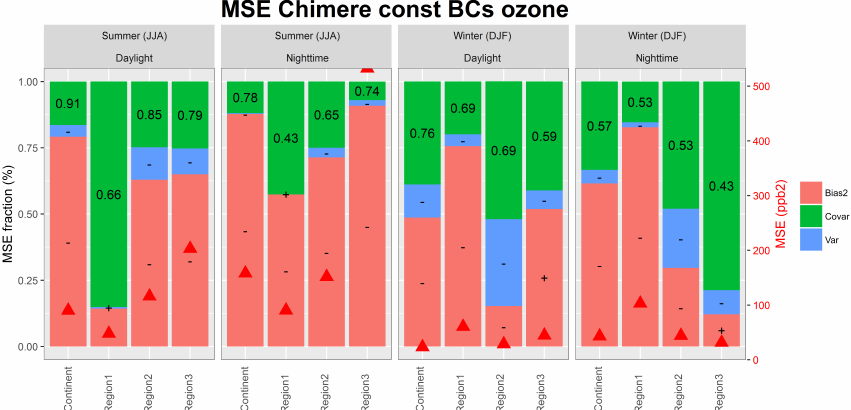
Figure 14. As in Fig. 11 for the hourly time series of the “constant boundary conditions” scenario.